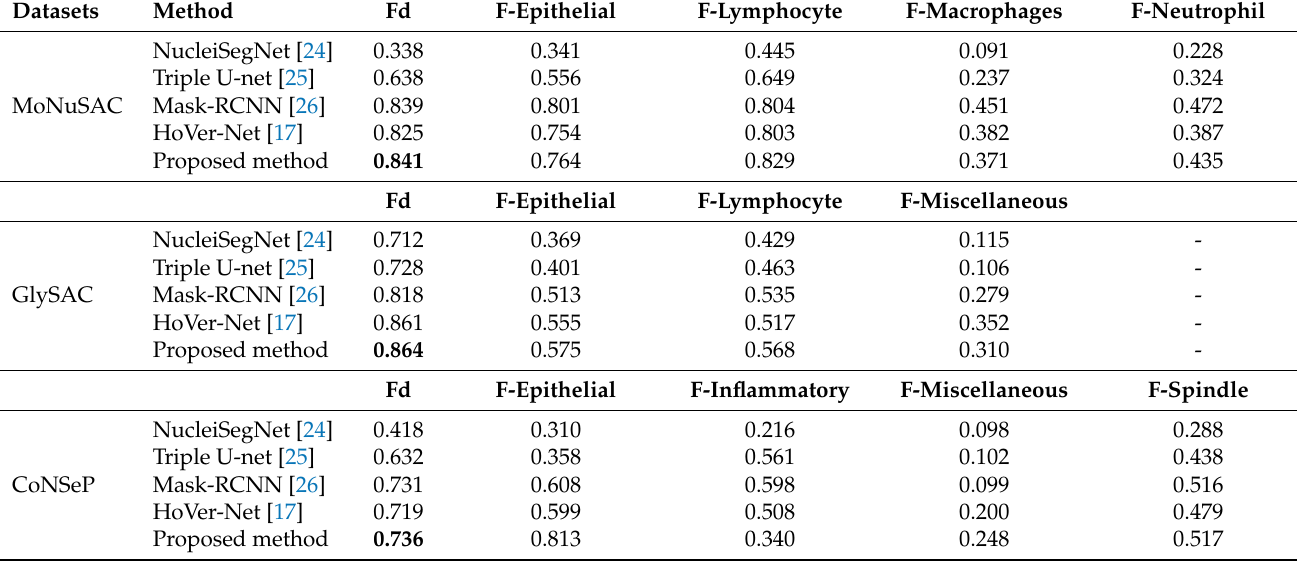
Table 1. Cell-classification results using in three datasets (MoNuSAC, GlySAC, and CoNSeP) and five